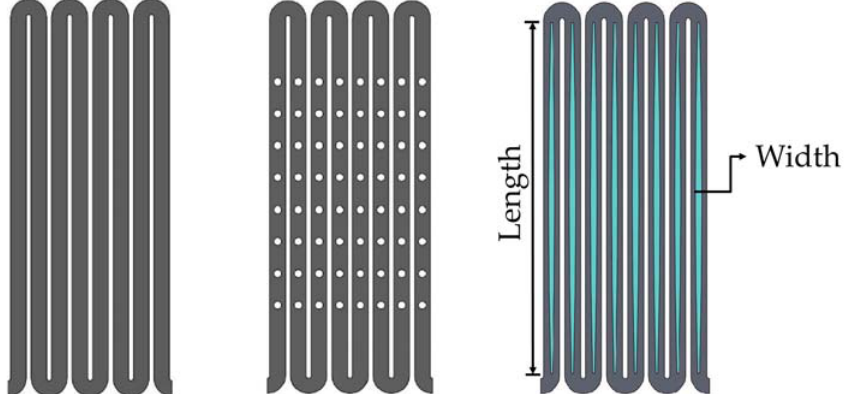
Figure 4. Conventional drug-eluting stent ( left ), conventional depot stent ( middle ), and our rhombic-shaped channel stent ( right ).